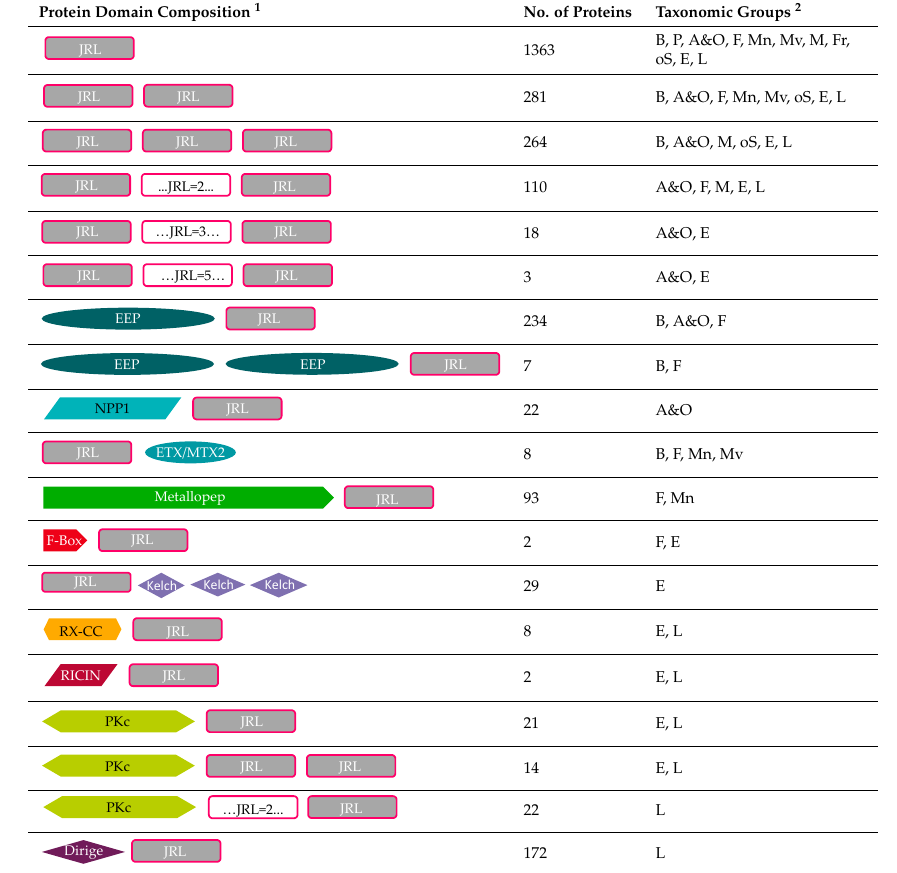
¹ JRL: Jacalin related lectin superfamily; EEP: Exonuclease-Endonuclease-Phosphatase superfamily; ETX/MTX2: Clostridium epsilon toxin ETX/Bacillus mosquitocidal toxin MTX2 superfamily; Metallopep: Metallopep superfamily, putative peptidase family; PKc: PKc like superfamily, Protein Kinases, catalytic domain; RX-CC: RX-CC superfamily, coiled-coil domain of the potato virus X resistance protein and similar proteins; F-Box: F-Box domain superfamily; RICIN: RICIN superfamily, Ricin-type beta trefoil, Carbohydrate-binding domain; Dirigent: Dirigent superfamily, Dirigent-like protein; Kelch: Kelch-1 superfamily , Kelch motif; NPP1: NPP1 superfamily, Necrosis inducing protein; ² B: Bacteria, P: Protozoon, A&O: Algae and Oomycetes, F: Fungi, Mn: Metazoa (non-